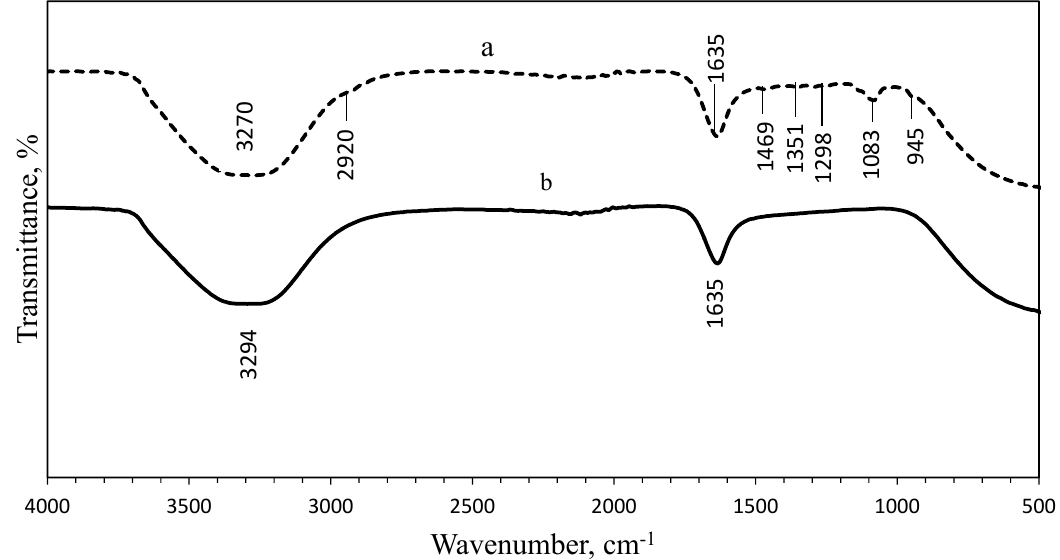
Figure 6. Comparison of FTIR spectrum between PEG-coated ( a ) and uncoated ( b ) biologically synthesised AgNPs.